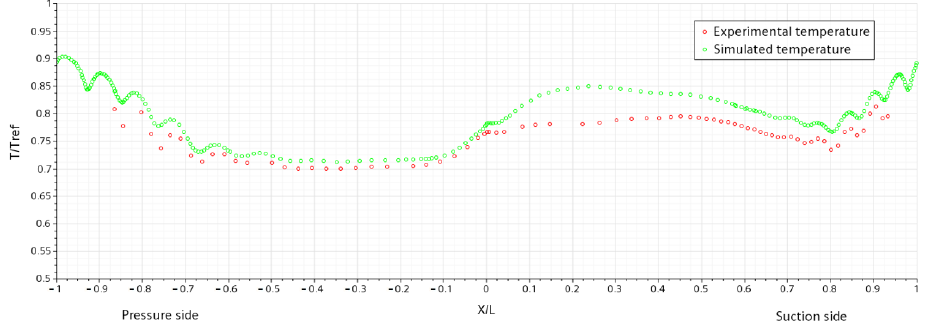
Figure 6. Comparison of the normalised temperature from the experimental report and the numerical simulations at mid-span. The reference temperature is 811 K, as reported in [11].